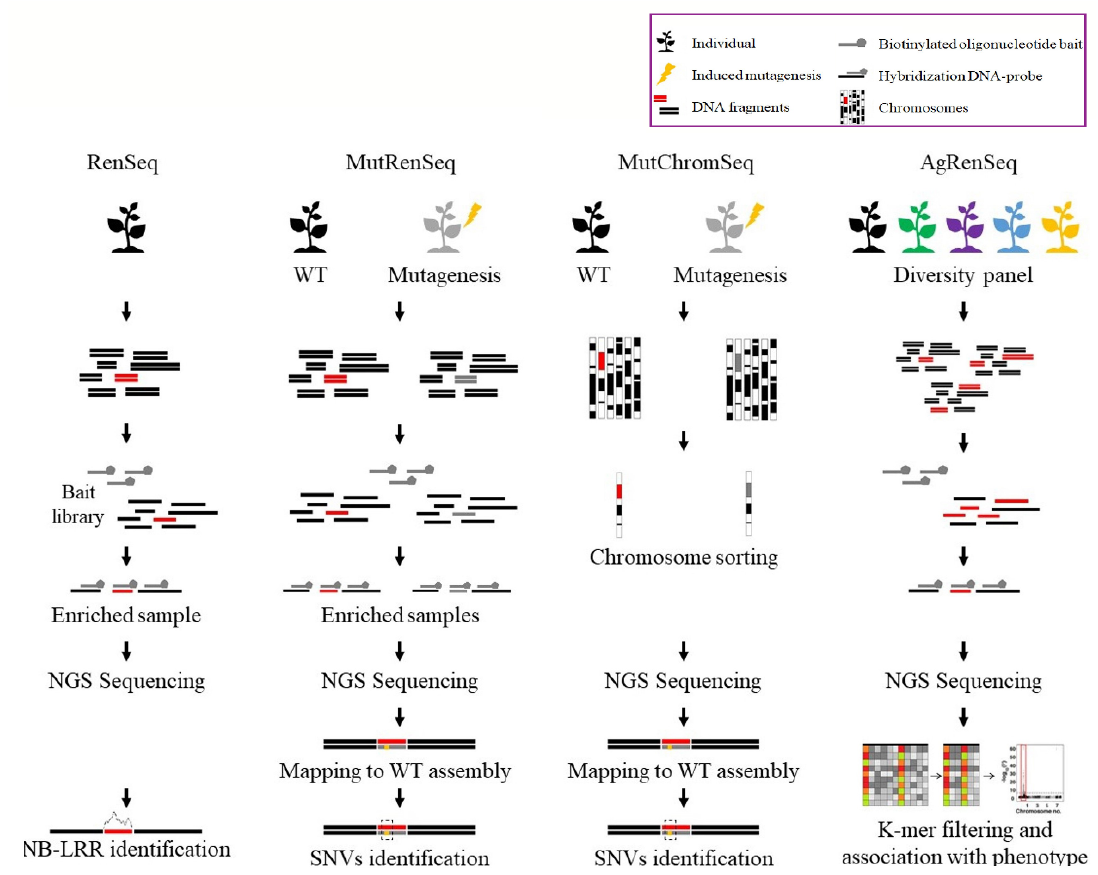
Figure 1. Overview of protocols for NLR discovering pipelines. Equal and differential steps are lined up to highlight the similarities/differences. WT: wild type. NGS: next generation sequencing. SNV: single nucleotide variant. A figure legend is on the upper right corner.